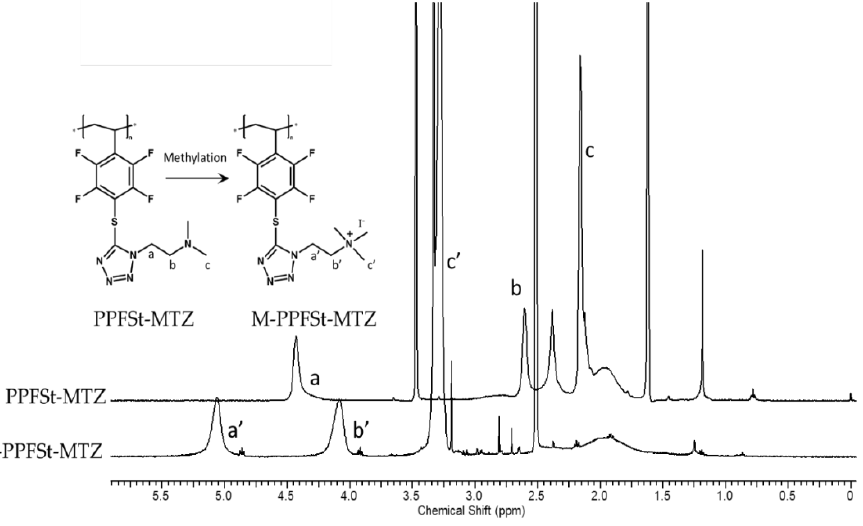
Figure 3. The 1 H-NMR spectra of PPFSt-MTZ and M-PPFSt-MTZ.